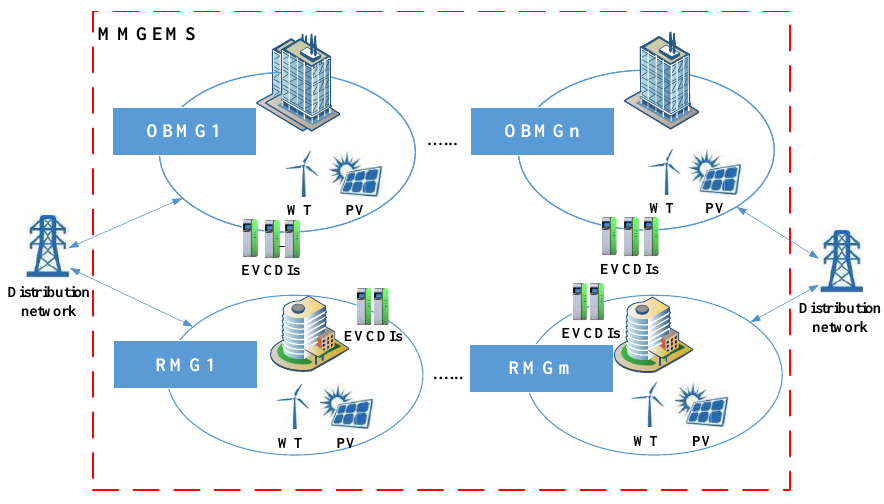
Figure 1. Structure of a DC multi-microgrid system.